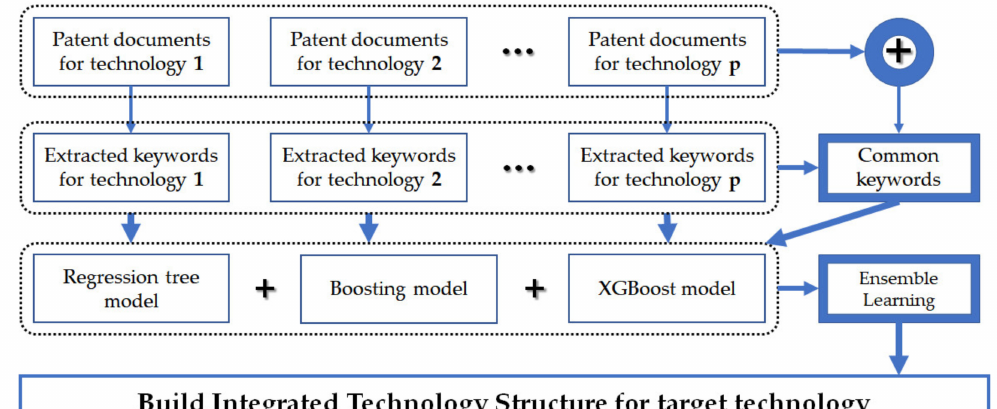
Figure 3. Proposed technology integration and analysis